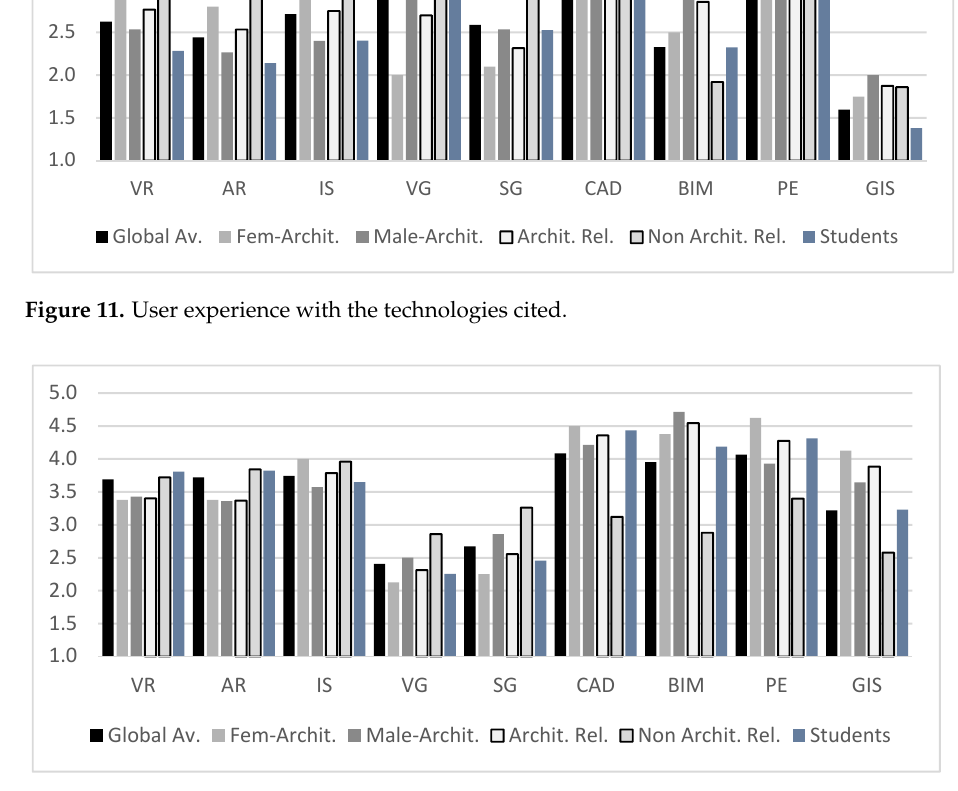
Figure 13. User motivation in future training.